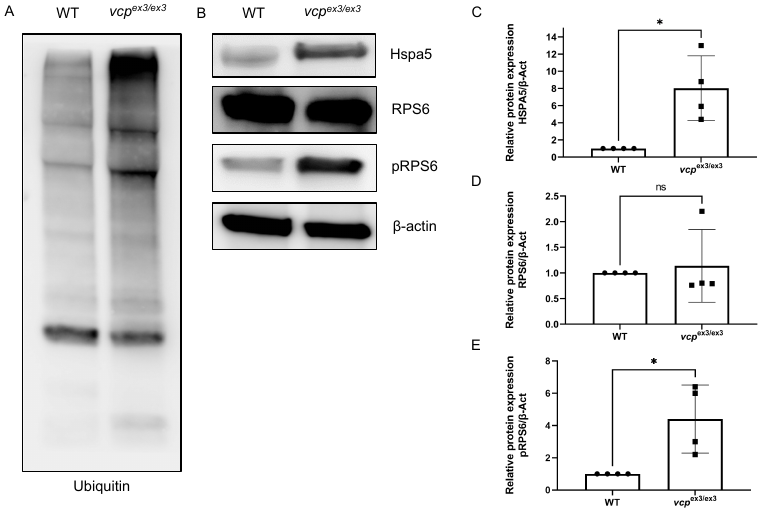
Figure 4. ER stress and impaired protein homeostasis in vcp ex3/ex3 embryos. ( A ) Loss of Vcp leads to an accumulation of ubiquitinated proteins in vcp ex3/ex3 embryos compared to WT controls (N = 4). ( B , C ) Significantly increased Hspa5 protein levels suggest ER stress in vcp ex3/ex3 embryos (N = 4; p = 0.0286; two-tailed t -test). Error bars indicate s.d.; * p < 0.05. ( B , D ) Total RPS6 protein levels are unchanged in vcp ex3/ex3 mutant embryos (N = 4; p = 0.0286; two-tailed t -test), whereas phosphoRPS6 protein levels. Error bars indicate s.d.; ns, not significant. ( B , E ) are significantly increased, suggesting an activation of mTORC1 signaling (N = 4; p = 0.0286; two-tailed t -test). ß-Actin was used as a loading control. Error bars indicate s.d.; * p < 0.05. ns: not